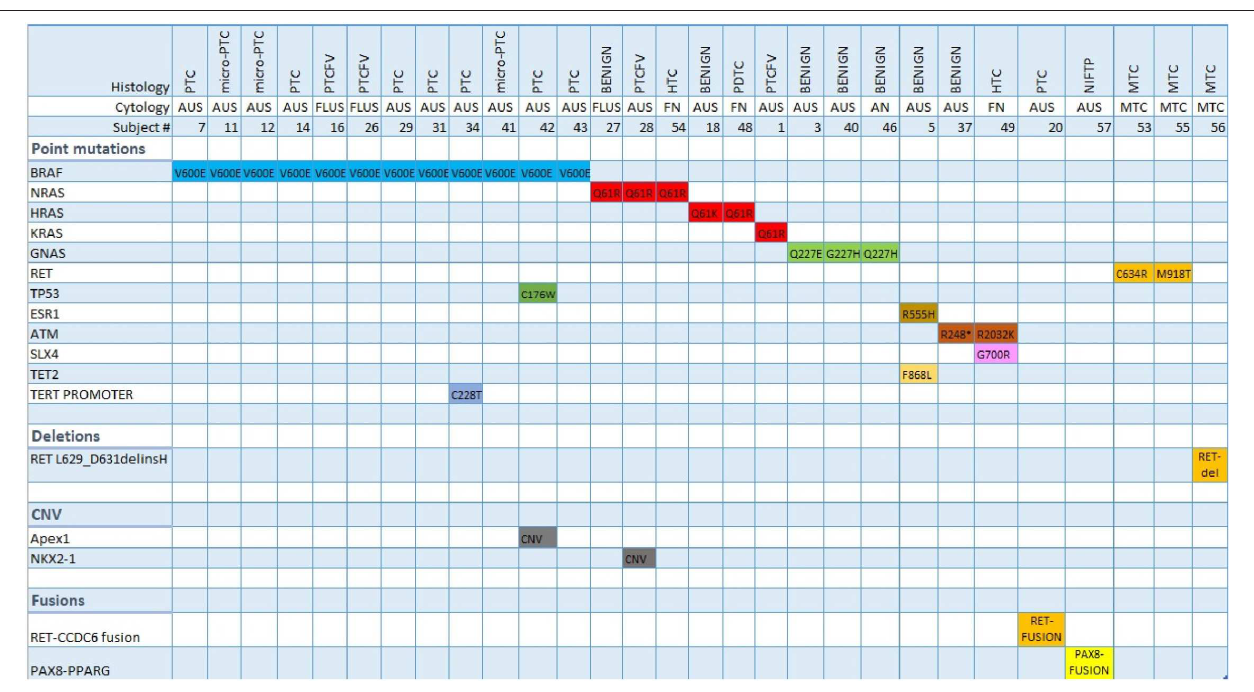
FIGURE 2 | Molecular signature (Oncoprint) of indeterminate thyroid nodules tested positive by Oncomine v2 assay. PTC, papillary thyroid carcinoma; PTCFV, papillary thyroid carcinoma follicular variant; NIFTP, non-invasive follicular thyroid neoplasm with papillary-like nuclear features; HTC, Hürthle cell thyroid carcinoma; PDTC, poorly differentiated thyroid carcinoma; MTC, medullary thyroid carcinoma; AUS, atypia of unknown significance; FLUS, follicular lesion of undetermined significance; FN, follicular neoplasm; AN, adenomatoid nodule; CNV, copy number variation.